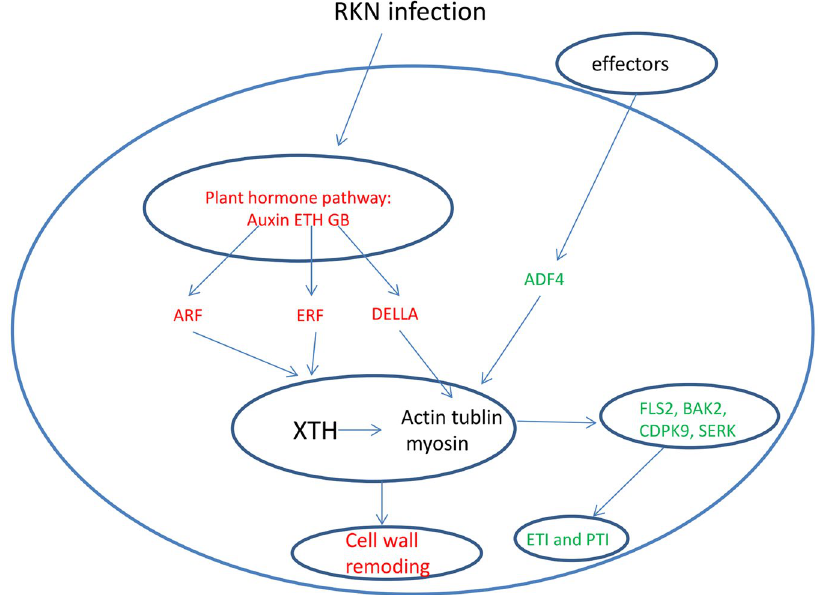
Figure 10. Overview of the roles of cytoskeleton related genes under RKN infection in Cm. A sketch for putative roles of cytoskeleton related genes in compatible and incompatible reaction of Cm to M i. Red represents compatible reaction and green represent incompatible